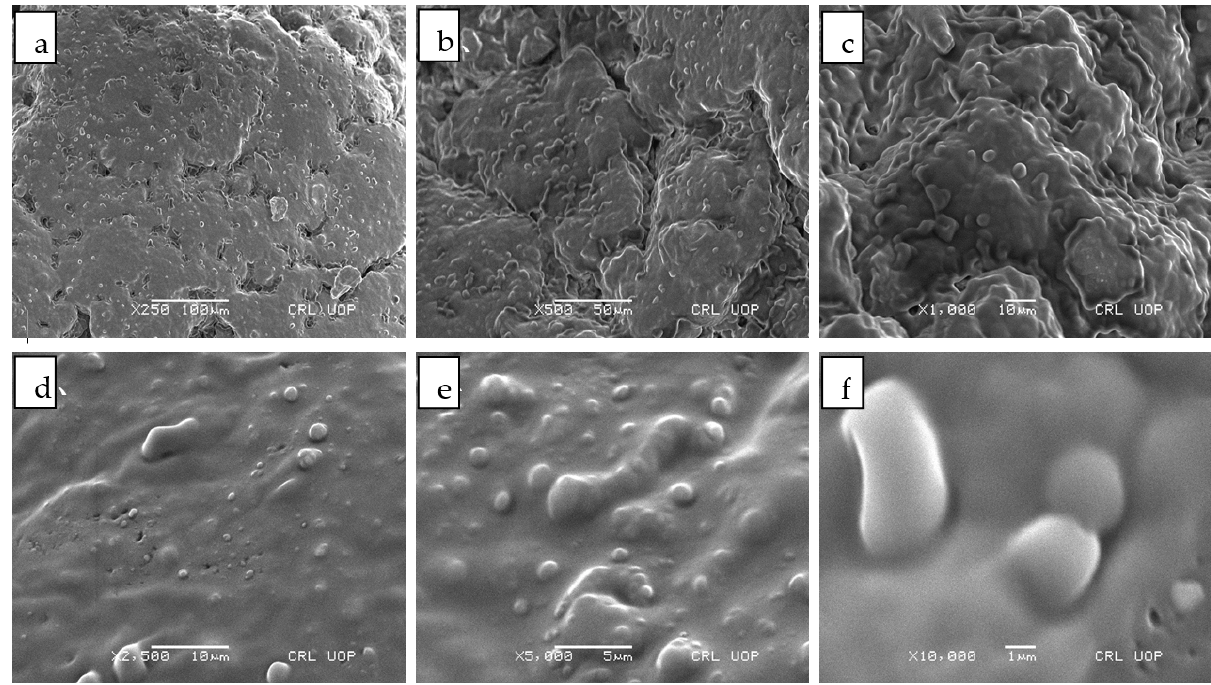
Figure 2. SEM images of T3 Formulation of Capsaicin loaded Nanocrystals ( a ) 250× ( b ) 500× ( c ) 1000× ( d ) 2500× ( e ) 5000× ( f ) 10000×.